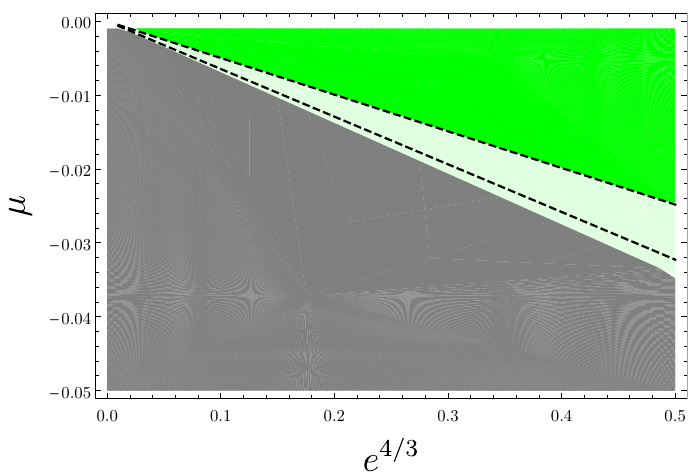
Figure 19 . Phase space of constraints in six dimensions . Here we show the situation for spherical black holes in six dimensions. Green shaded areas represent a single physical critical point. Light green areas represent two physical critical points. In the gray regions, there are no solutions to the critical point equations (6.2). In the region between the dashed black lines, the Wald entropy is negative for one of the two critical points.